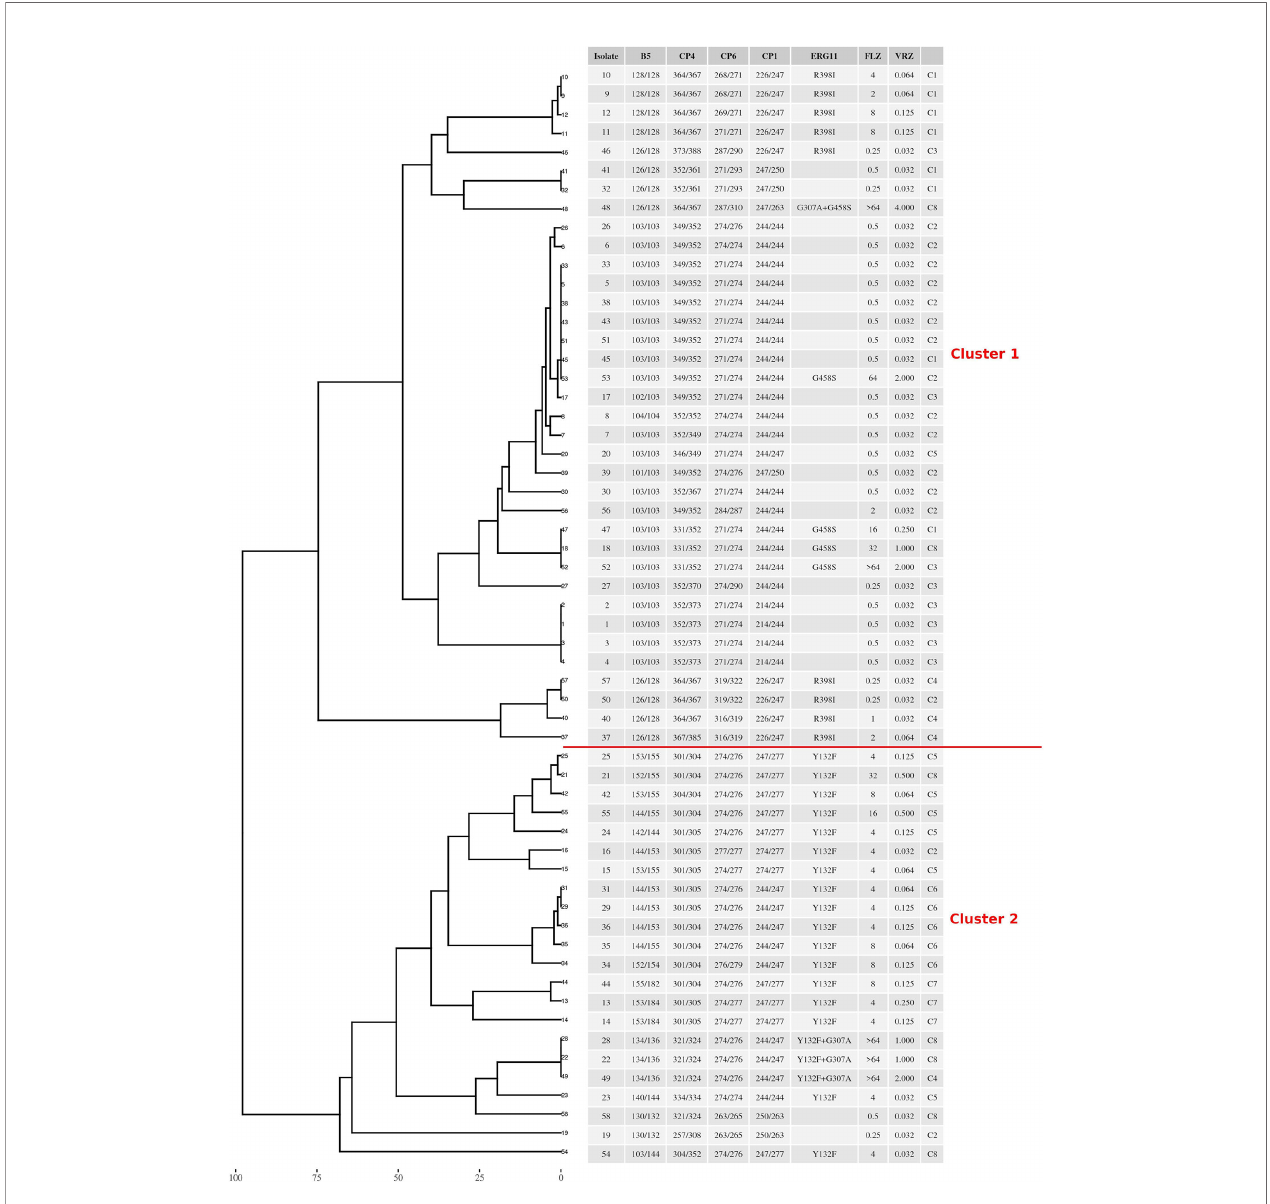
FIGURE 3 | The genotypic relatedness of C . parapsilosis blood isolates recovered during 2019 to 2020 in Ege University Hospital reveals clonal outbreak due to both azole-susceptible and azole-non-susceptible isolates. C denotes minor cluster containing similar genotypes (difference ≥ 2